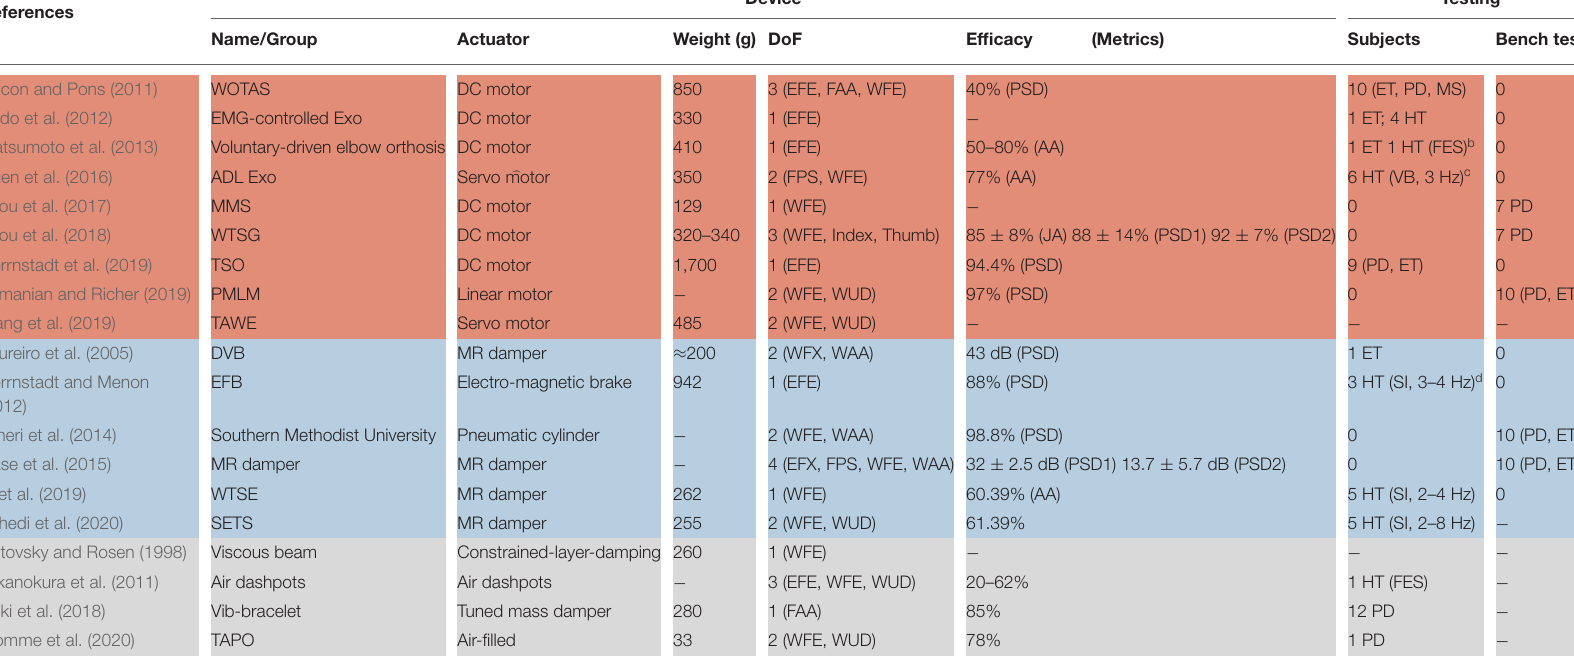
TABLE 1 | Upper-limb orthoses for tremor